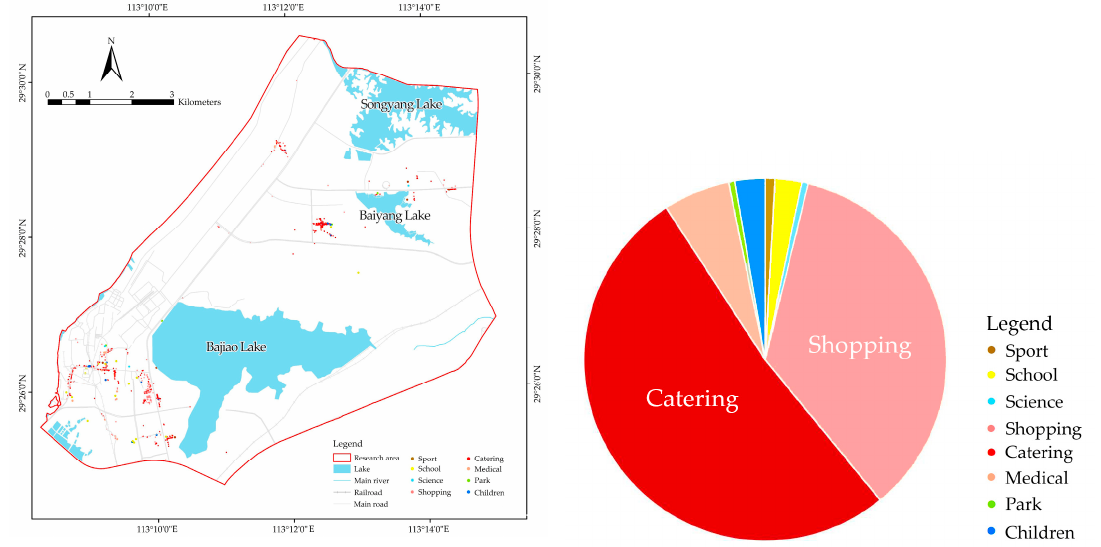
Figure 4. Map of the spatial distribution and proportion of the number of various types of POI public service facilities.